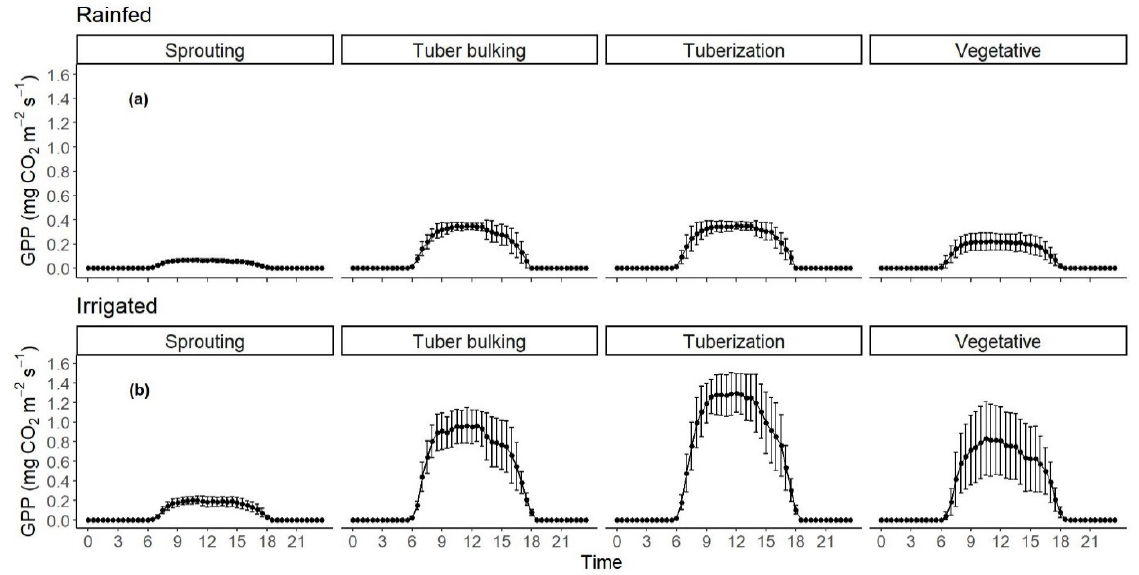
Figure 4. Half-hourly variation of gross primary production (GPP) of ( a ) Rainfed and ( b ) Irrigated potato crop in four different growth stages (sprouting, vegetative, tuberization, tuber bulking). Half-hourly averages are plotted. Vertical bars indicate the standard deviation.